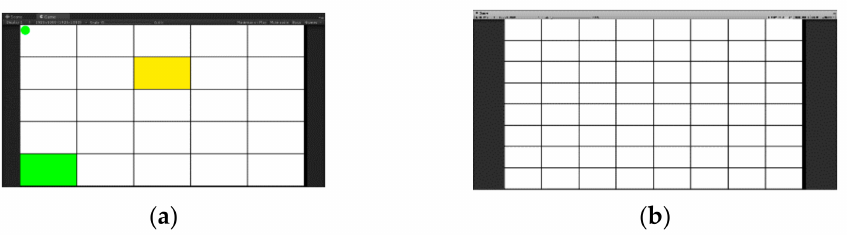
Figure 4. The experiment interface of Experiments 1 and 2: ( a ) experiment interface of the 5 × 5 level; ( b ) experiment interface of the 8 × 8 level.